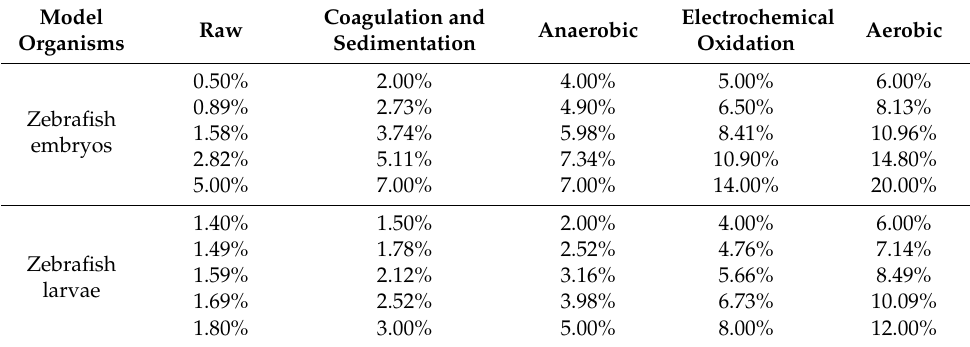
Table 1. Experimental concentration